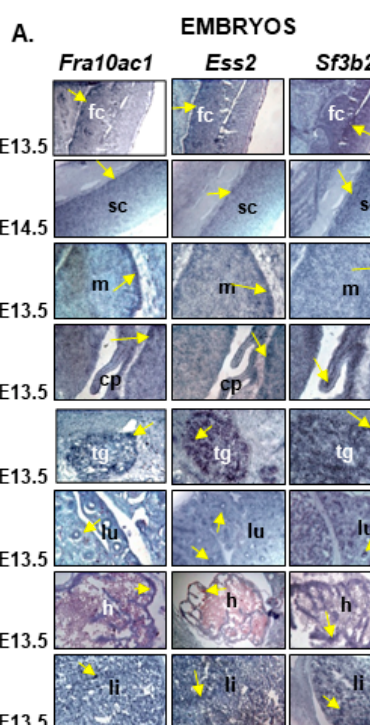
Along the same lines, we examined the subcellular localization of FRA10AC1 in com- parison with that of ESS2 and SF3B2. Co-localization of all three proteins exclusively in the nucleoplasm was observed when EGFP-FRA10AC1 and Xpress-ESS2 were transiently expressed in HeLa cells, while the endogenous SF3B2 was detected by using an anti-SF3B2- specific polyclonal antibody (Figure 3B).